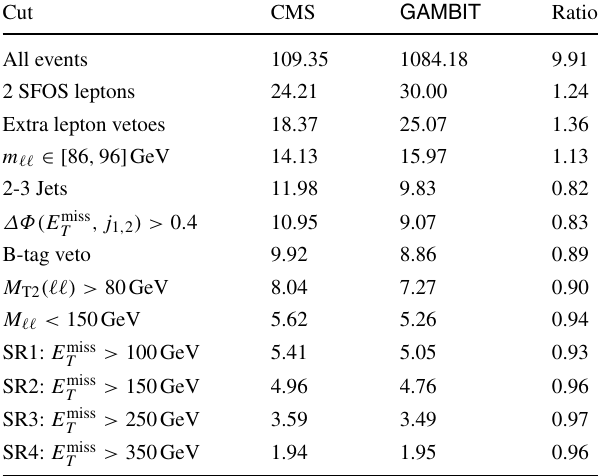
Table 6 Comparison of the GAMBIT and published CMS cutflows [126] in four signal regions of a search for new physics in events with two opposite-charge same-flavor leptons and missing transverse momentum, for a W Z signal model ( m ˜ χ ± GeV). Shown are the numbers of events expected in 35.9 fb − 1 of 13 TeV CMS data, and the ratio of the GAMBIT and CMS numbers. Note that the CMS cutflow is generated for a ˜ χ ± ing via W / Z where the Z boson decays leptonically, while the GAM- BIT cutflow is generated without specifying Z boson decay mode. This explains the discrepancy at the “All events”